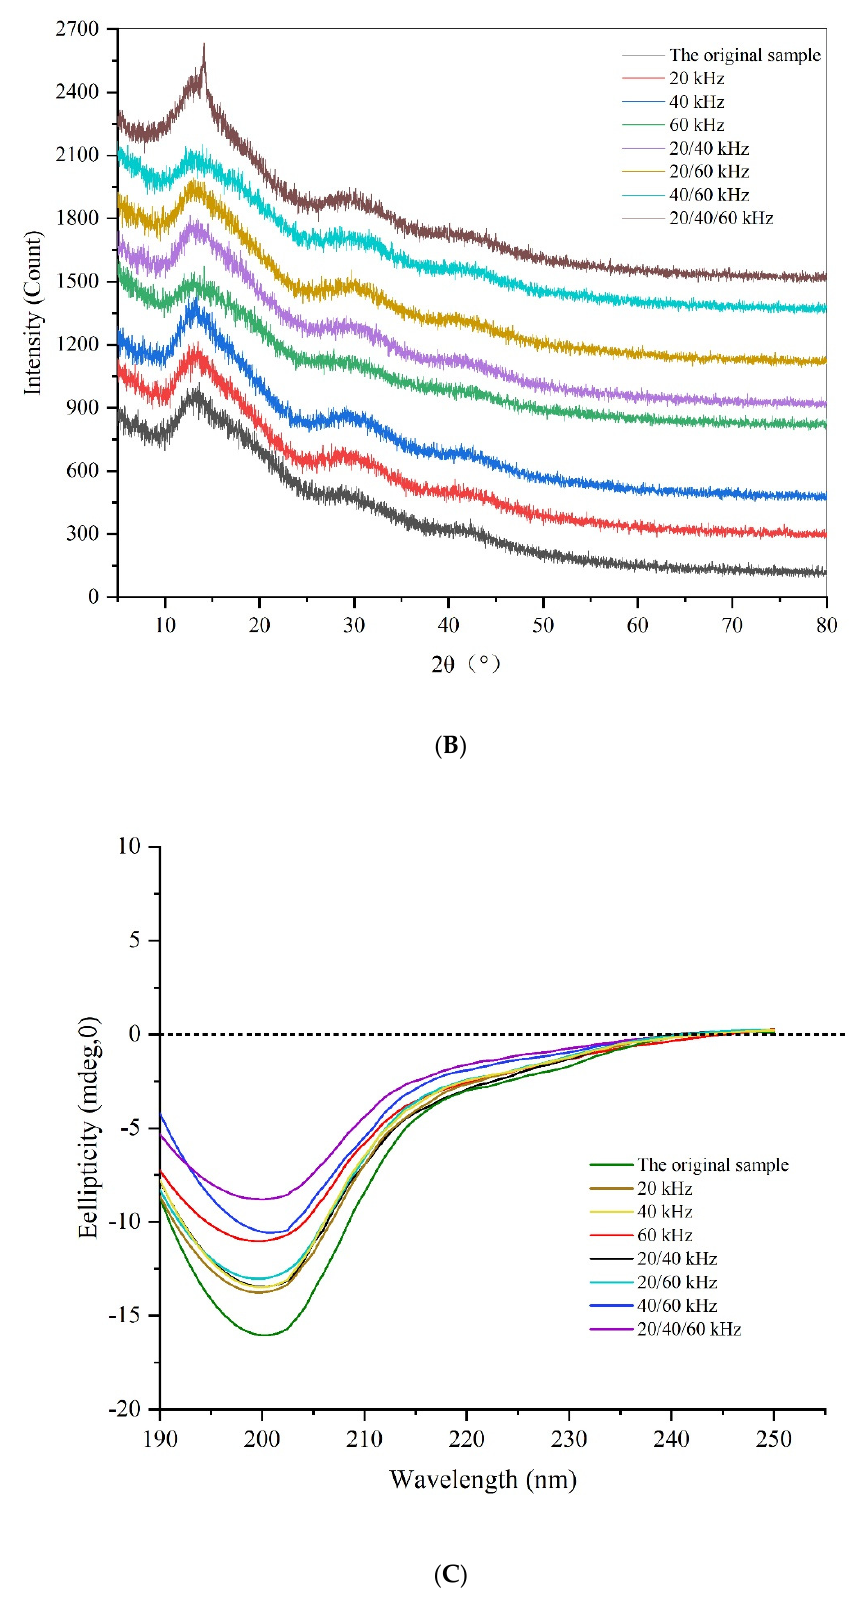
Figure 4. Morphology of lentinan before and after different frequency and combined ultrasound treatment according to atomic force microscopy ( A ), X − ray diffraction spectra ( B ), and CD analysis ( C